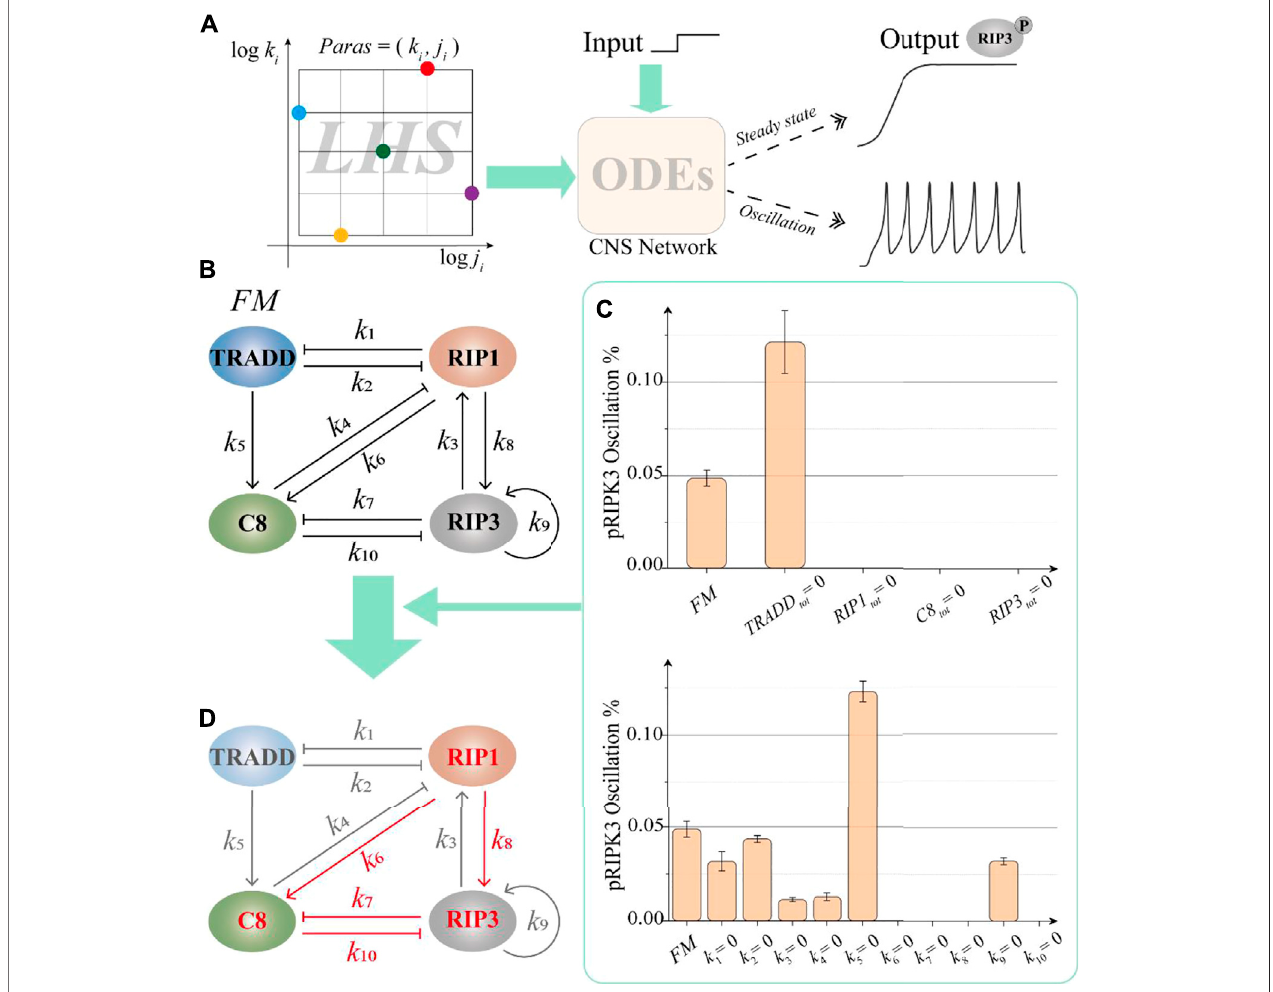
FIGURE 2 | Identi fi cation of the essential structure in the CNS circuit. (A) The Latin Hypercube Sampling method analysis procedure for a set of given parameters. The dynamic behavior of pRIP3 is the object of investigation. (B) The full model (FM) contains four major proteins and ten interaction terms, in which each interaction is controlled by the corresponding parameters. (C) The statistical results of the circuit oscillation probability after removing one protein or one interaction, respectively. (D) The red mark highlights the essential structure of the CNS circuit for generating oscillation.